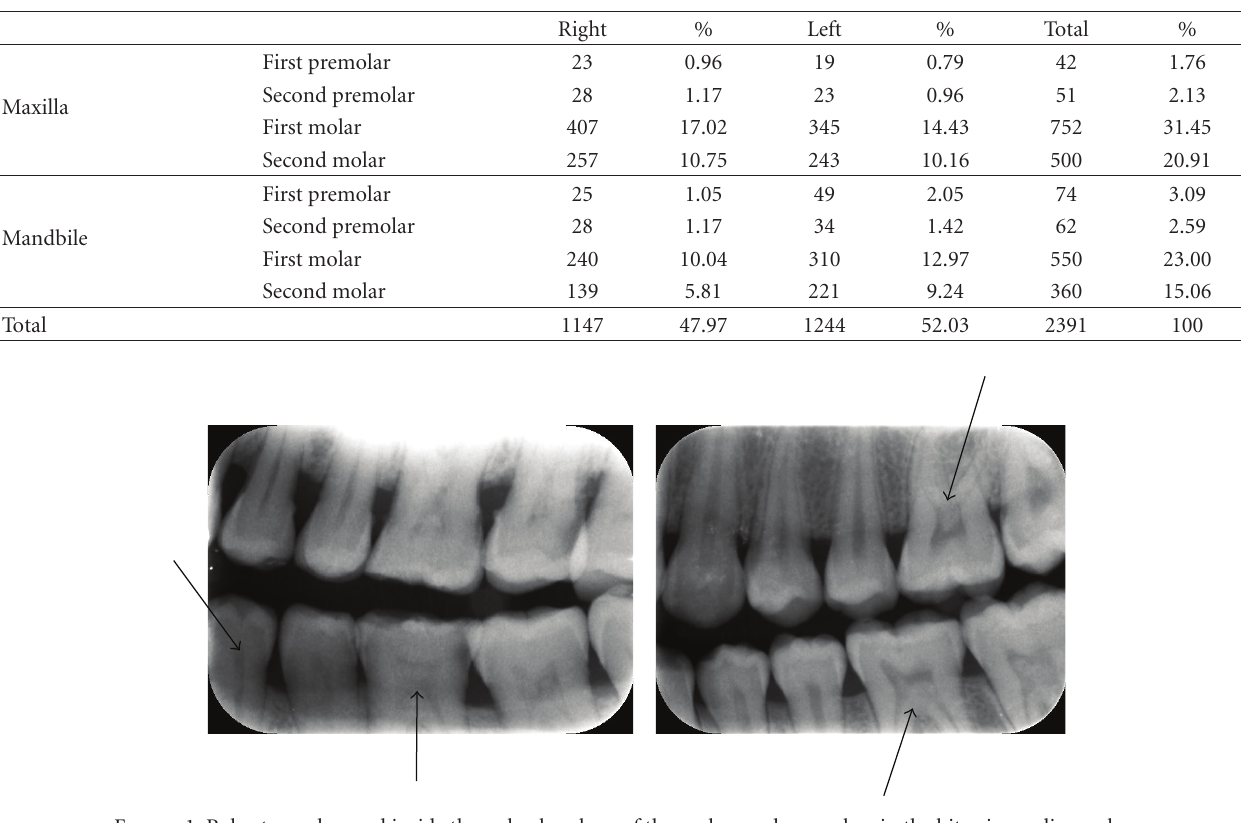
shown an overall prevalence of 63.6% for individuals